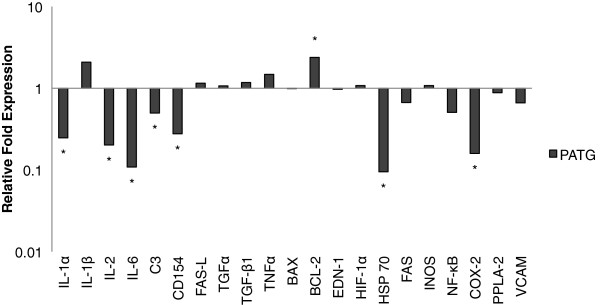
Gene transcript expression in liver tissue of PATG relative to the control group. Median value of relative fold expression is depicted on a logarithmic scale. >2 fold difference from control was considered statistically significant and is indicated by *.